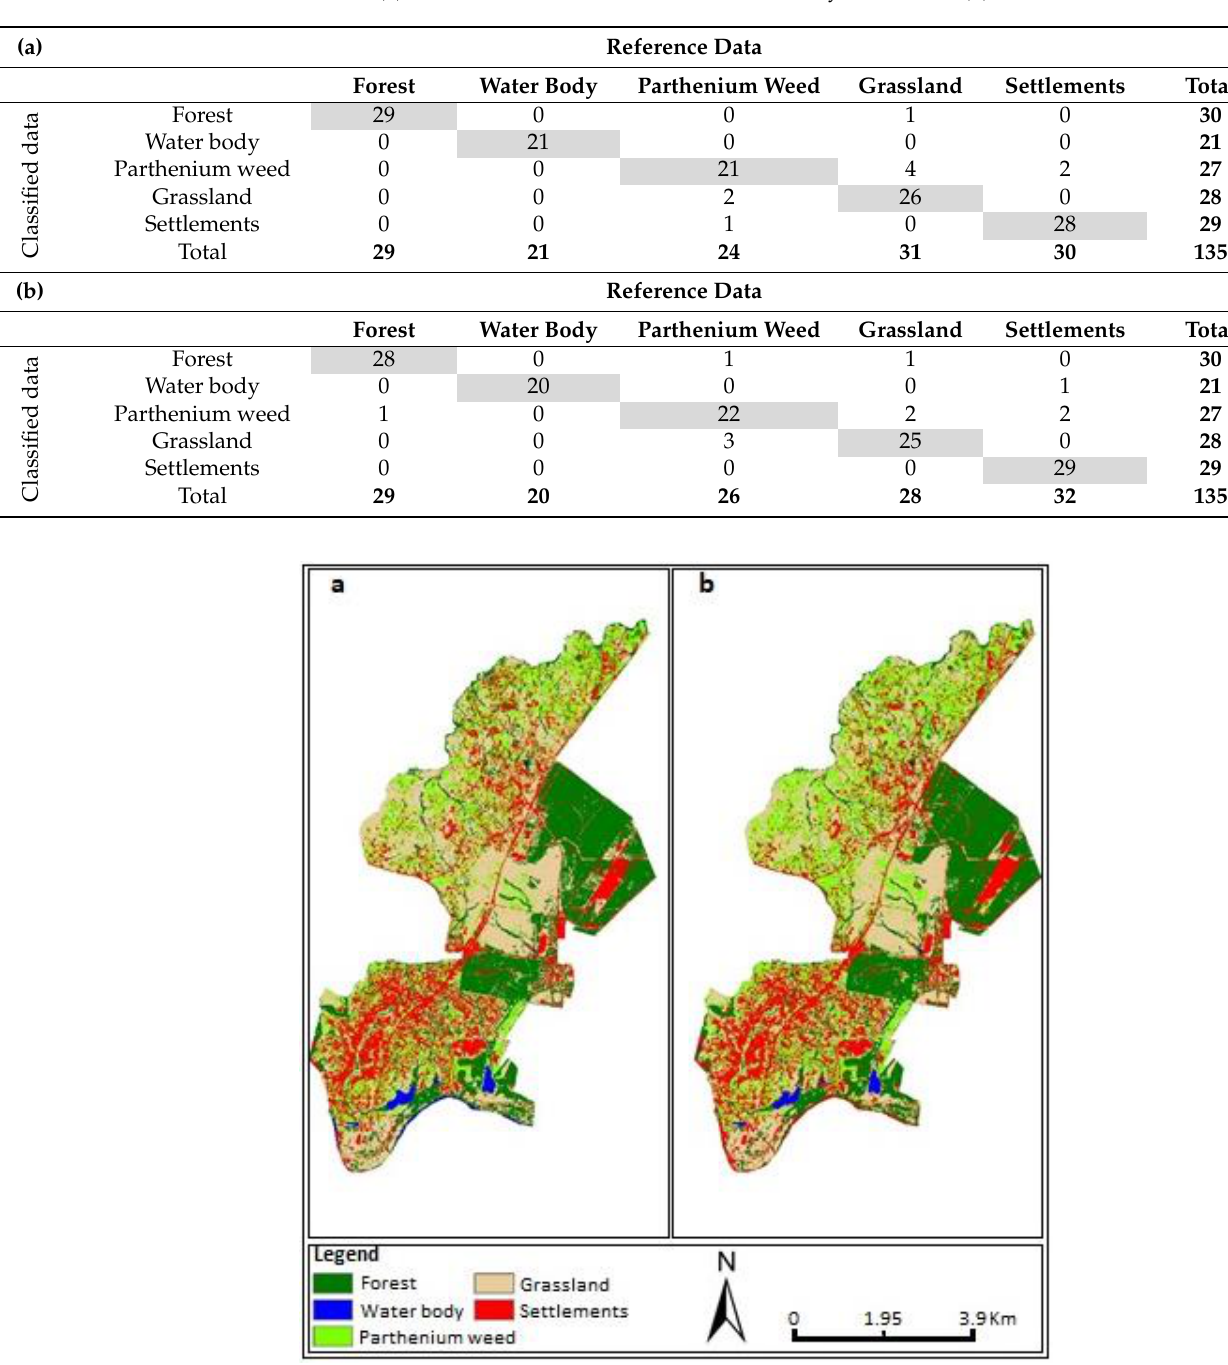
Table 4. (a) Error matrix of ReliefF-svmb-EXT-TPOT hybrid model. (b) Error matrix of TPOT alone.